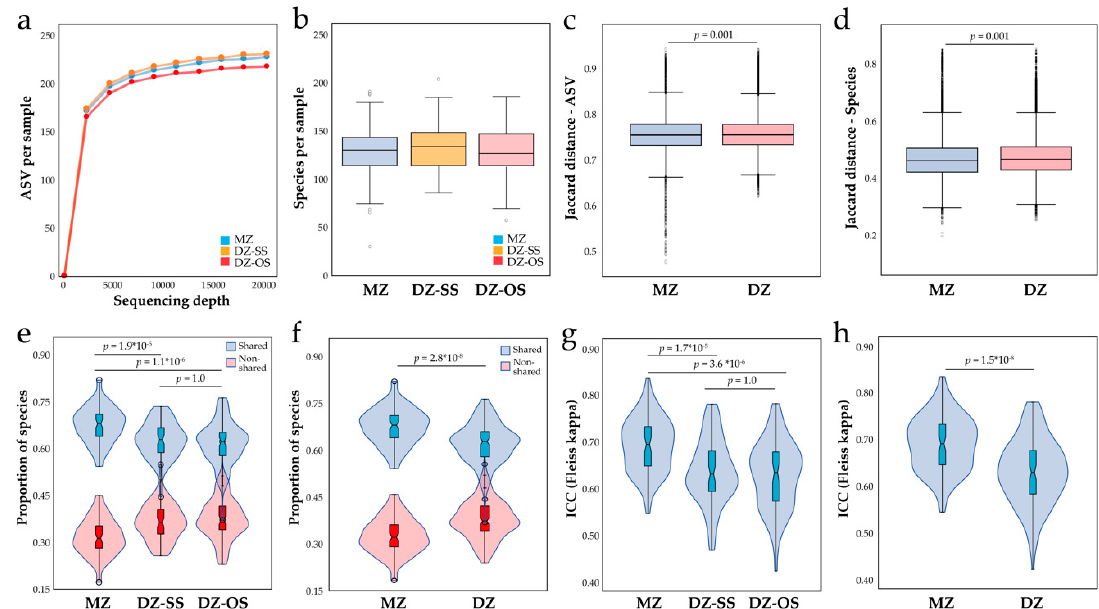
Figure 2. Overall microbiota comparisons between MZ and DZ groups. ( a ) alpha diversity of MZ, DZ-SS, and DZ-OS twin groups based on rarefaction curves of identified ASVs per sample, and ( b ) number of eHOMD-identified species in the same groups. ( c ) Box plot of Jaccard diversity index based on ( c ) ASV profiles and ( d ) eHOMD species detection. Violin plots showing ( e ) pair-wise proportions of shared and non-shared species in the three zygosity groups and ( f ) MZ and merged DZ twin groups. Intraclass qualitative estimation agreement based on Fleiss’ kappa values for ( g ) MZ, DZ-SS, and DZ-OS twin groups and ( h ) MZ and merged DZ groups. The Mann–Whitney U tests were used for group comparisons.